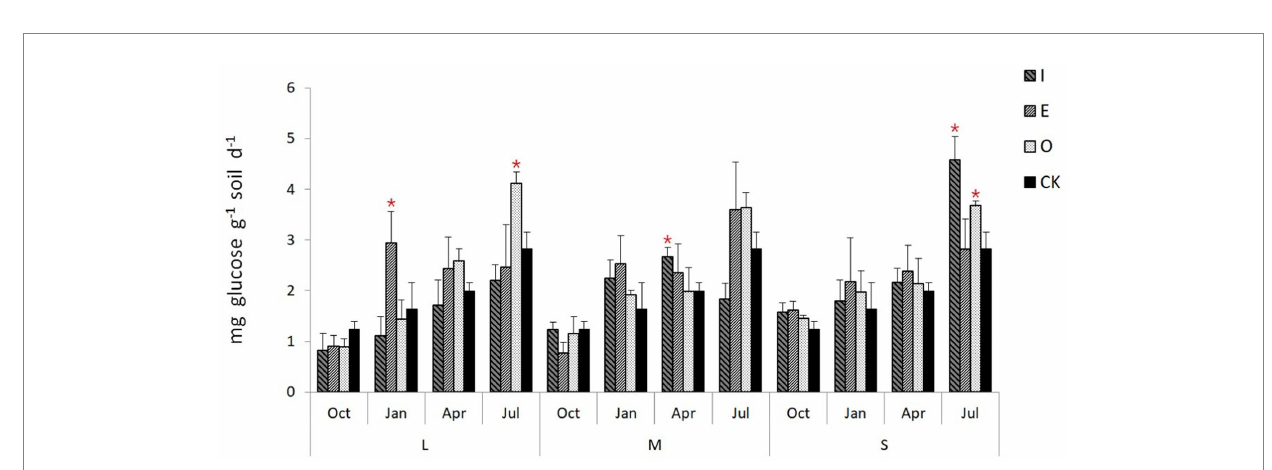
FIGURE 7 Soil invertase activity of different position in different sizes of gaps, the “*“signs represent significant differences.